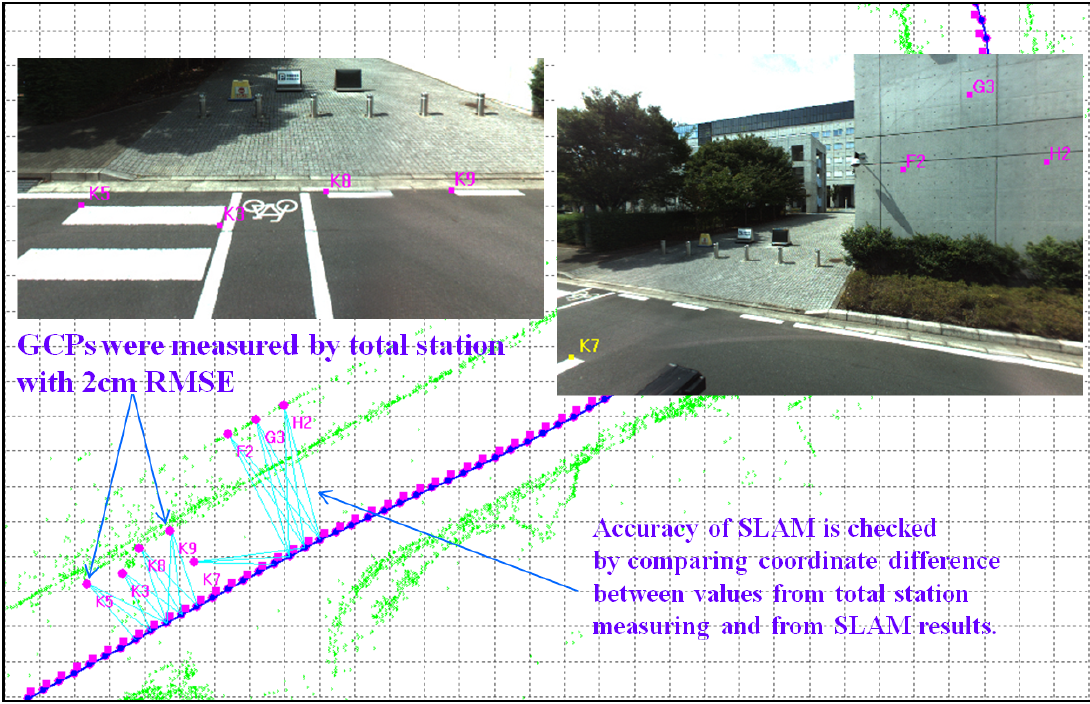
Figure 7. The eight GCPs, with accuracy up to 2 cm, are used in the experiments to check the accuracy of the GPS-supported